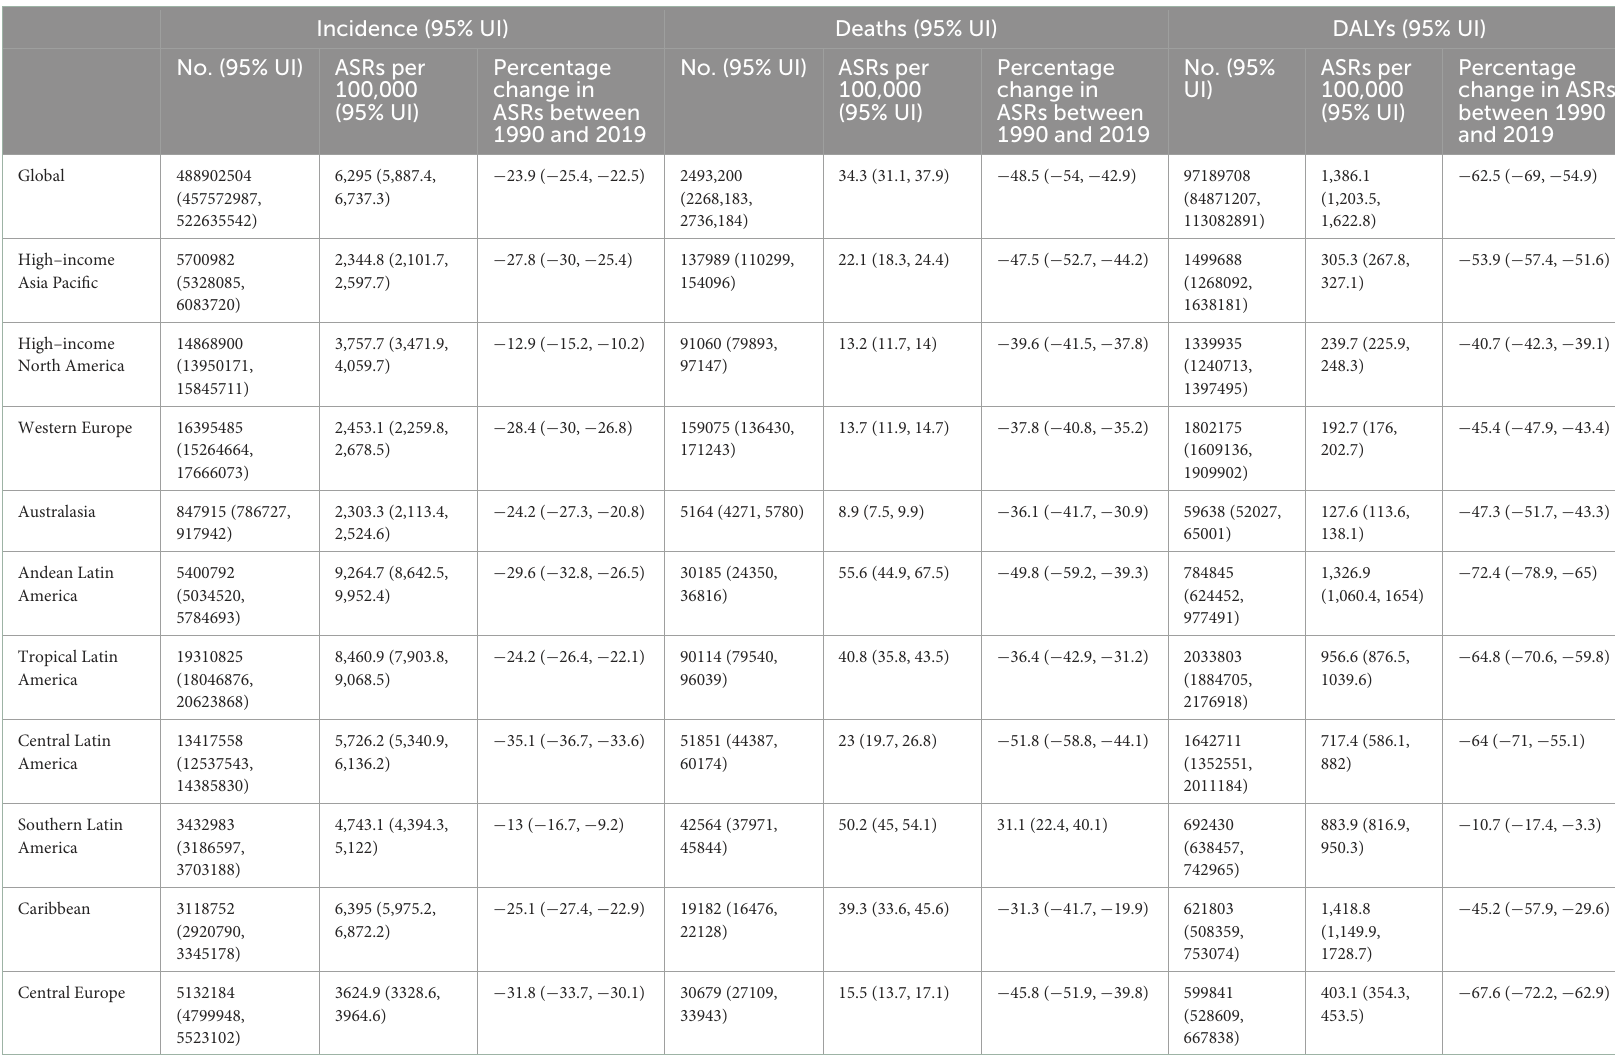
TABLE 1 Incident cases, deaths and DALYs for lower respiratory infection in 2019 and percentage change in the age- standardised rates (ASRs) per 100,000, by GBD region, from 1990 to 2019 (generated from data available from http://ghdx.healthdata.org/gbd-results-tool